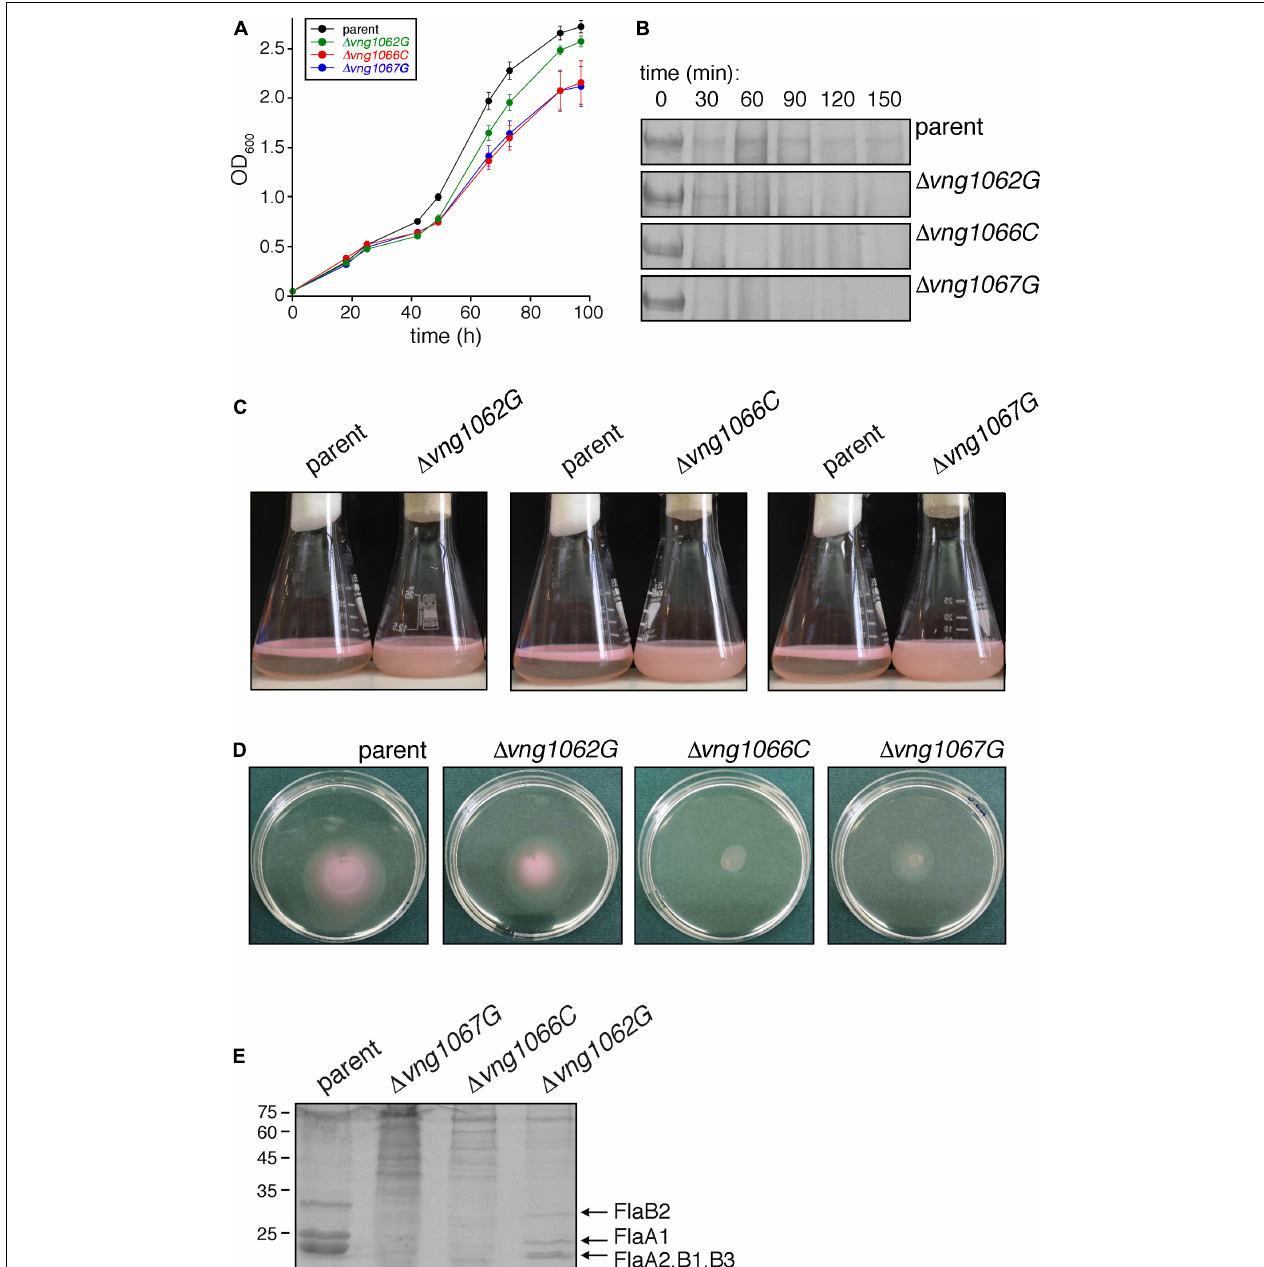
FIGURE 1 | The absence of VNG1062G, VNG1066C or VNG1067G affects various aspects of Hbt. salinarum behavior. (A) Growth of (cid:49) vng1062G , (cid:49) vng1066C , and (cid:49) vng1067G strains is compromised, relative to the parent strain. Each point represents the average of three biological repeats ± standard error of the mean. (B) Exposure of the S-layer of the (cid:49) vng1062G , (cid:49) vng1066C , and (cid:49) vng1067G strains to added proteinase K leads to more rapid digestion of the S-layer glycoprotein, relative to what occurs when the parent strain is similarly treated. Shown are regions of 8% SDS-PAGE gels containing the Coomassie-stained S-layer glycoprotein found in the different cultures challenged with the protease for the indicated intervals. (C) Stationary phase cells of the parent, (cid:49) vng1062G , (cid:49) vng1066C , and (cid:49) vng1067G strains were left unperturbed overnight. Cells of the mutant cultures remain dispersed in the medium, whereas cells of the parent strain collect at the medium-air interface. (D) Cell motility is compromised in the (cid:49) vng1062G , (cid:49) vng1066C , and (cid:49) vng1067G strains. Aliquots (10 µ l) of liquid cultures of the parent and mutant strains in logarithmic phase were applied to the center of Petri dishes containing solid medium that included 0.3% agar (w/v). After 3 days at 42 ◦ C, the diameter of the halo that appeared was measured. Where the halos were not perfectly circular, the diameter was considered as the average of the longest and shortest linear spans of the halo area. Three plates each were assessed per strain. A representative set of plates is presented. (E) Lower amounts of archaellins are found in the spent growth media of the (cid:49) vng1062G , (cid:49) vng1066C , and (cid:49) vng1067G strains than of the parent stain. Archaellins were isolated as described in the “Materials and Methods,” separated by SDS-PAGE and Coomassie-stained. The positions of molecular weight markers are indicated on the left, while the different archaellins are indicated on the